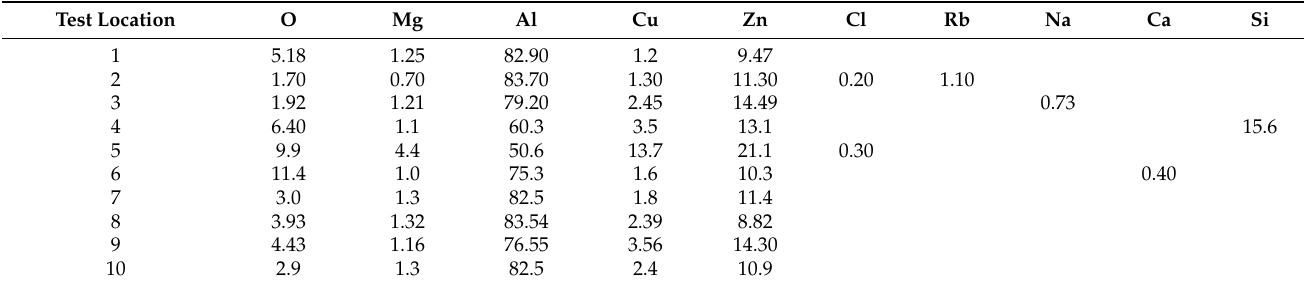
Table 2. Content of each chemical component of inclusions in the melt before and after ultrasonic treatment